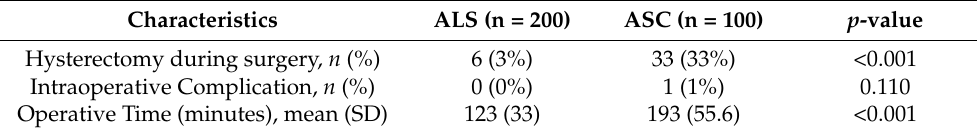
Table 2. Post-operative demographic characteristics. Data are presented as n (%) or as median values ± SD. Characteristics comparing ALS vs. ASC after surgery were statistically analyzed with two-tailed Fisher’s exact test or by two-tailed Mann–Whitney test, accordingly. p -values < 0.05 were considered statistically significant. ALS: abdominal lateral suspension; ASC: abdominal sacral colpopexy.